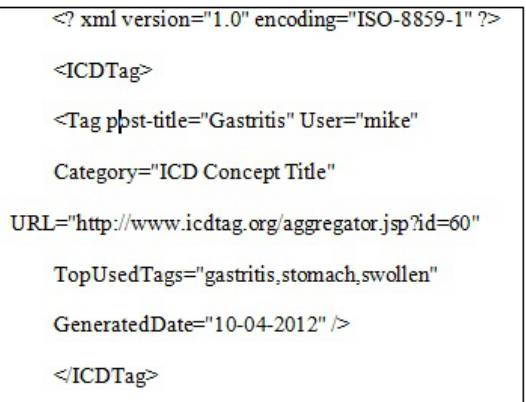
Figure 12. An XML fragment representing a stable